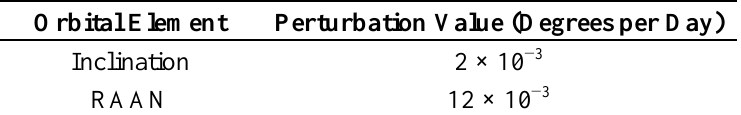
Table 1. Impacts of perturbations on some GEO SAR orbital elements in a short period. RAAN, right ascension of the ascending node.